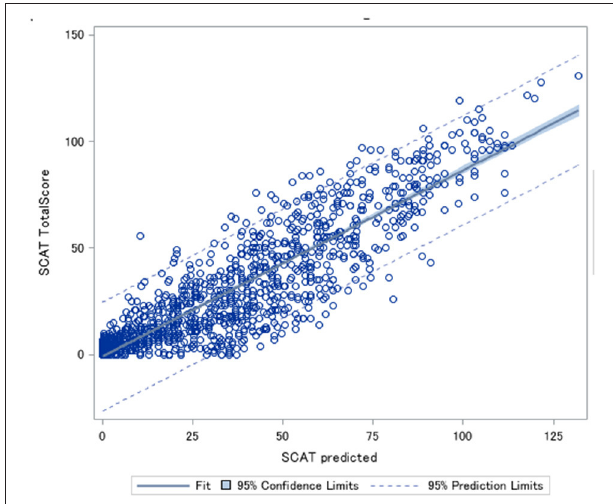
FIGURE 3 | Predicted Sports Concussion Assessment Tool (SCAT) scores plotted against the actual SCAT scores.